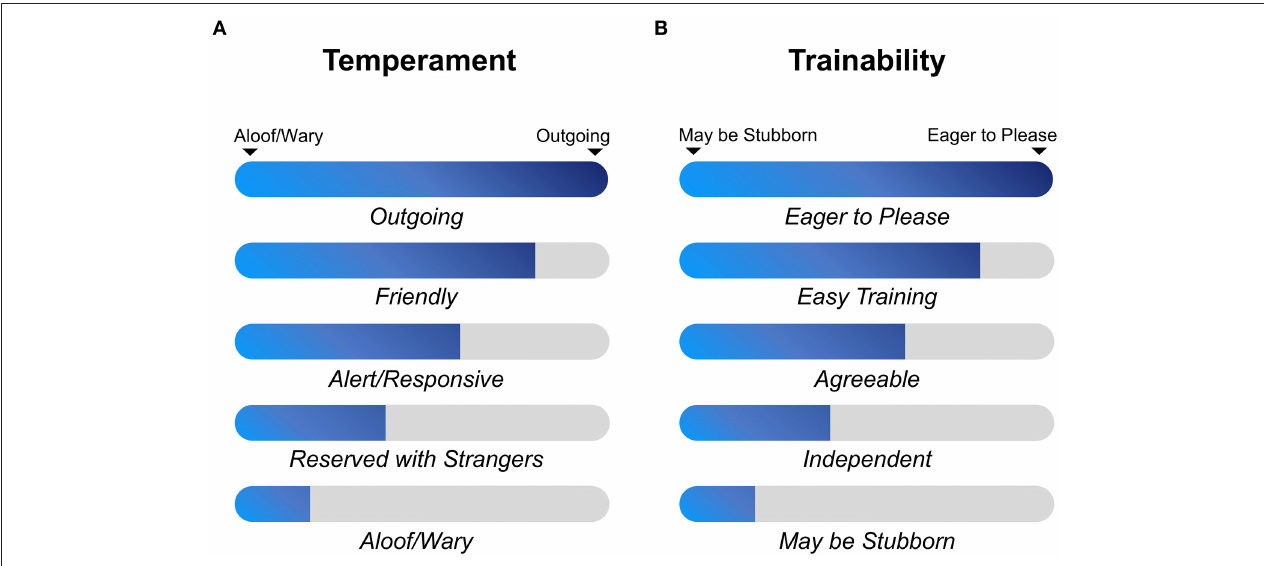
FIGURE 1 | Classifications of trainability and temperament traits among modern dog breeds. Trait level information is obtained from AKC website (https://www.akc. org/dog-breeds/) (accessed on 20 December 2020), and each breed has a specific score for one of these five phenotype levels. (A) Aloof/wary, reserved with strangers, alert/responsive, friendly and outgoing were used to describe temperament character of each dog breed stereotype. (B) May be stubborn, independent, agreeable, easy training and eager to please were applied to describe trainability character of each dog breed stereotype.